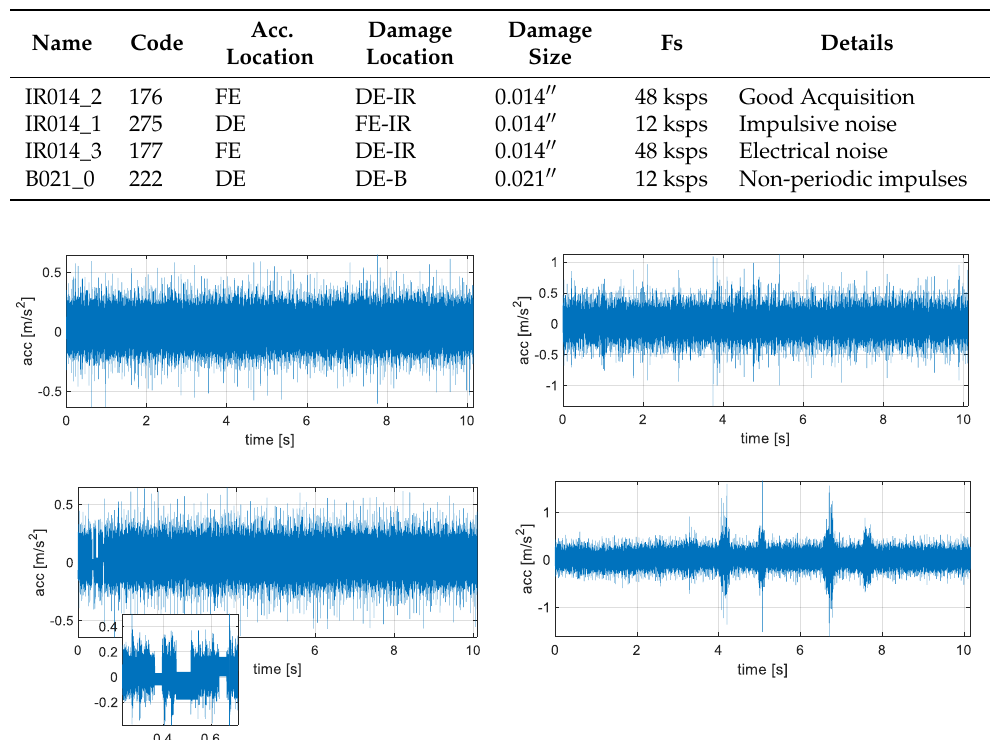
Figure 3. Time series of the 4 cases of interest: 176FE (top left), 275DE (top right), 177FE (bottom left) with a zoom over the anomaly, 222DE (bottom right).